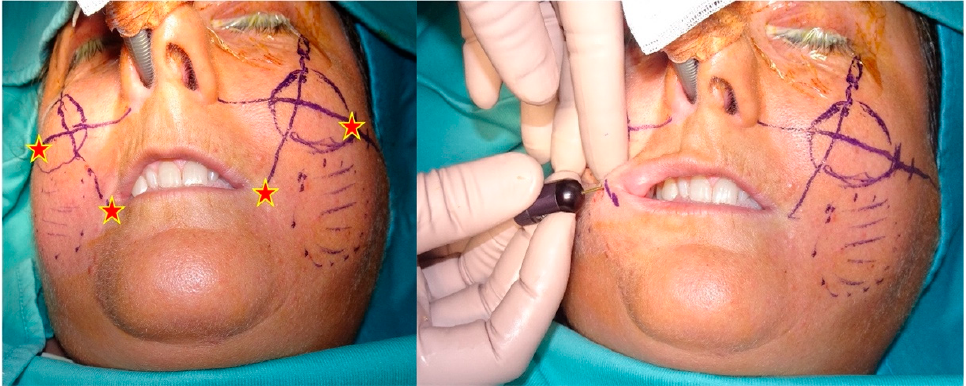
Figure 1. Harvested fat processing procedure sequence .